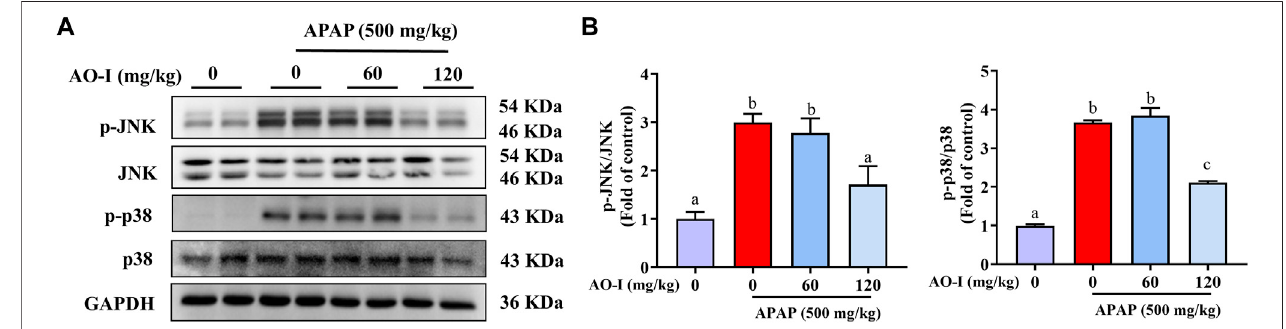
FIGURE 5 | AO-I inhibits APAP-induced MAPK signaling pathway. (A) Effects of AO-I on APAP-induced p-JNK and p-p38 expression in the liver. (B) Quantitative map of p-JNK and p-p38 protein expression. All data are presented as the mean ± SEM. Bars with different characters present statistically signi fi cant results, p <